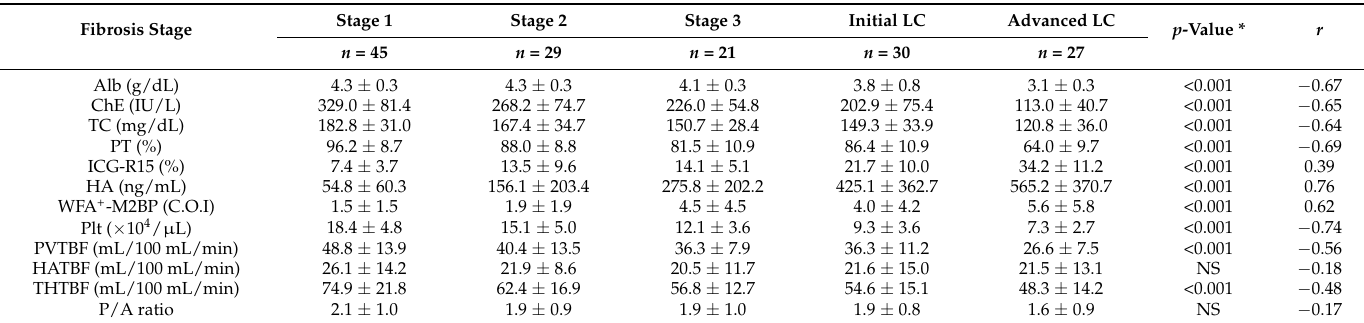
Table 4. Liver function and hepatic tissue blood flow in each fibrosis stage in